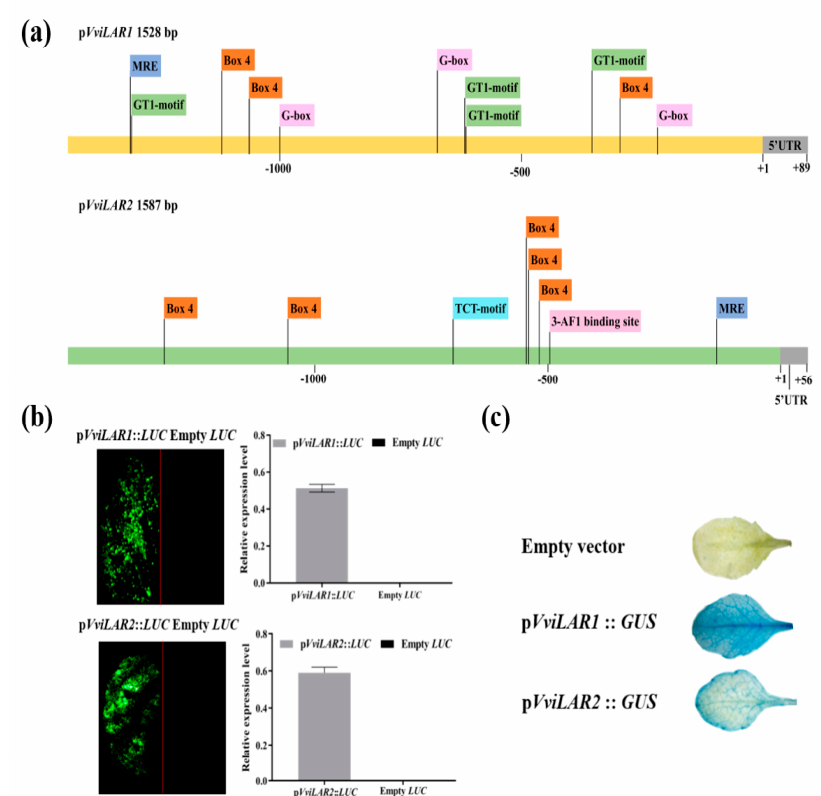
Figure 5. Sequence analysis and examination of the cloned promoter activity. ( a ) The putative cis -acting elements in both orientations of the p VviLAR1 and p VviLAR2 predicted by the PlantCARE website, only light-responsive elements (LREs) are shown; ( b ) tobacco leaves were transformed with equal amount of p VviLARs :: LUC construct (left side) and Empty LUC construct (right side), respectively. Left panel: fluorescence imaging. Right panel: relative expression of LUC estimated by image J software; ( c ) GUS staining on the expression of GUS driven by promoters in the Arabidopsis leaves.